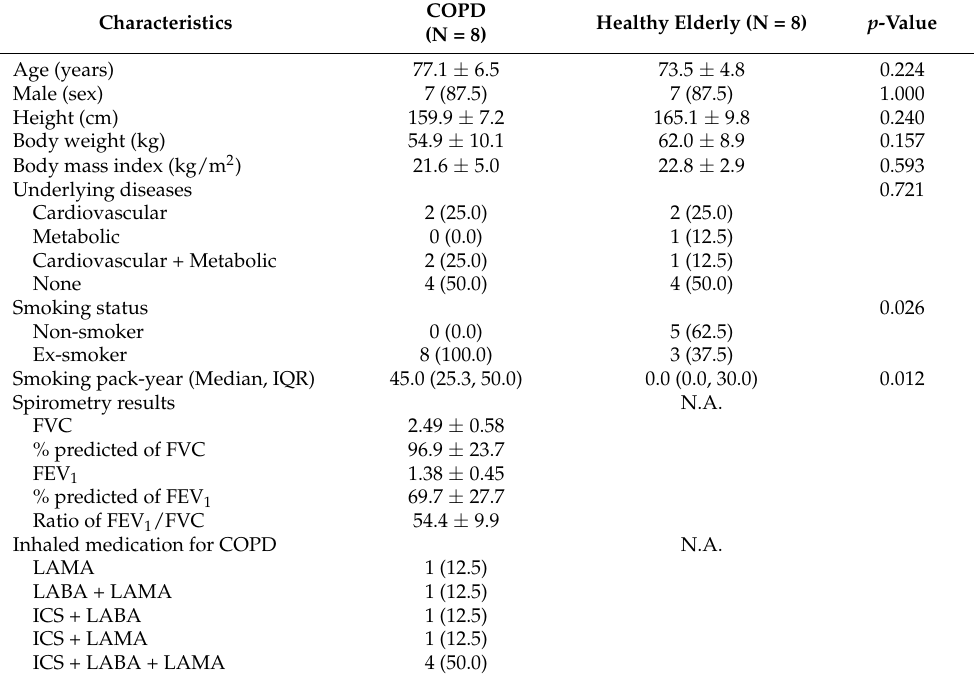
Table 1. Demographic and clinical characteristics of